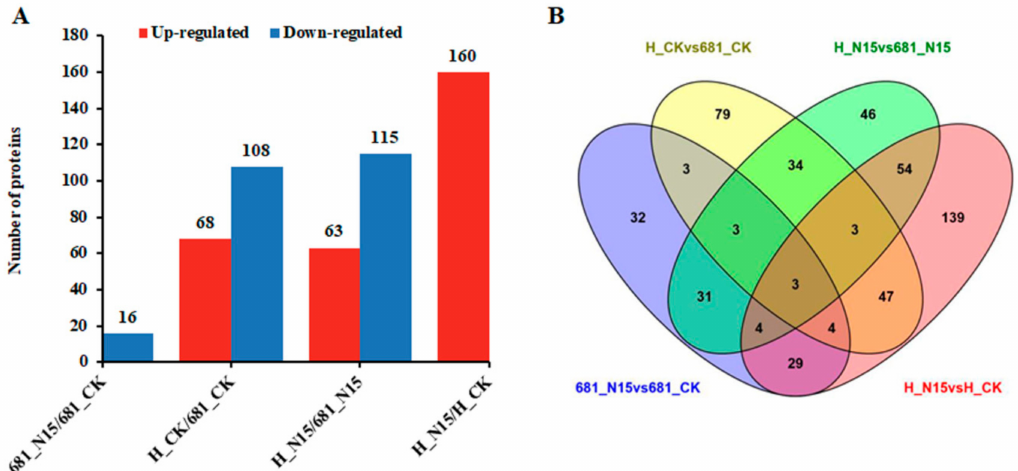
Figure 2. Histogram ( A ) and Venn diagram ( B ) of the number distribution of di ff erentially expressed proteins in di ff erent comparison groups. Proteomics analysis was performed on the roots of the two rice cultivars at booting stage with / without treatment of N15 (225 kg / hm 2 nitrogen fertilizer). N15 represented rice under nitrogen fertilizer treatment with the concentration of 225 kg / hm 2 , while control check (CK) represented the control without nitrogen fertilizer treatment; 681 and H represented Quanliangyou 681 and Huanghuazhan cultivars, respectively. Proteins with threshold change fold > 2 and p value < 0.05 were regarded as up-regulated, while quantitative ratio < 0.5 and p value < 0.05 were considered as